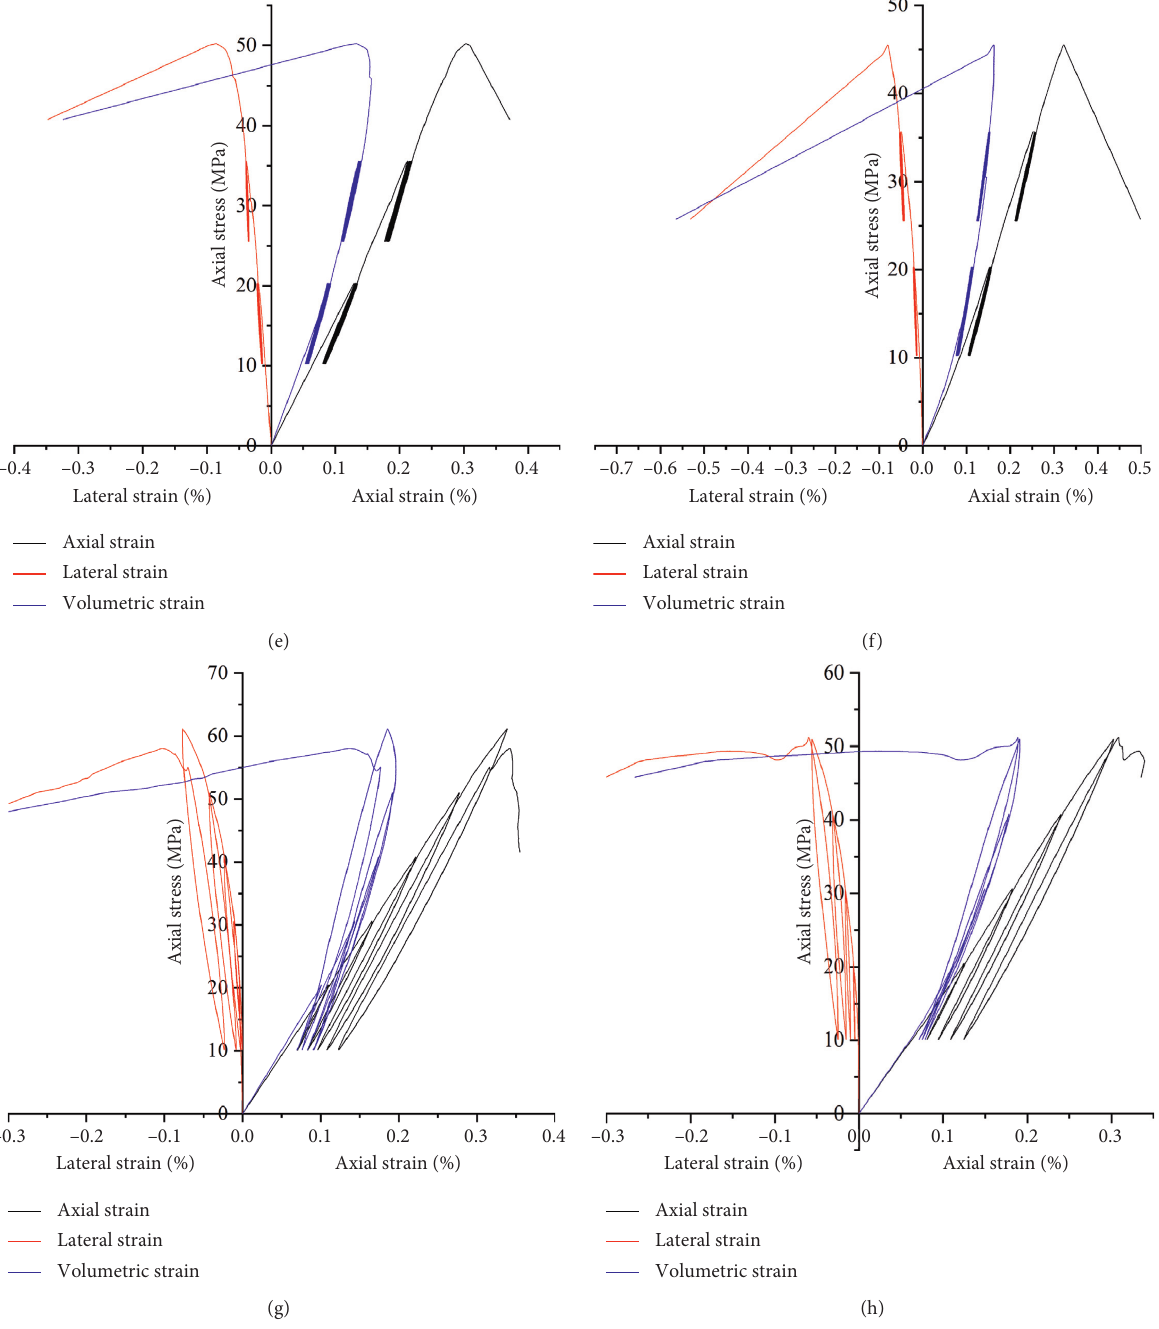
Figure 7: The stress-strain curves of rock samples subjected to different stress paths: (a) NF1; (b) FT1-3; (c) NF2; (d) FT2; (e) NF3; (f) FT3; (g) NF4; (h)